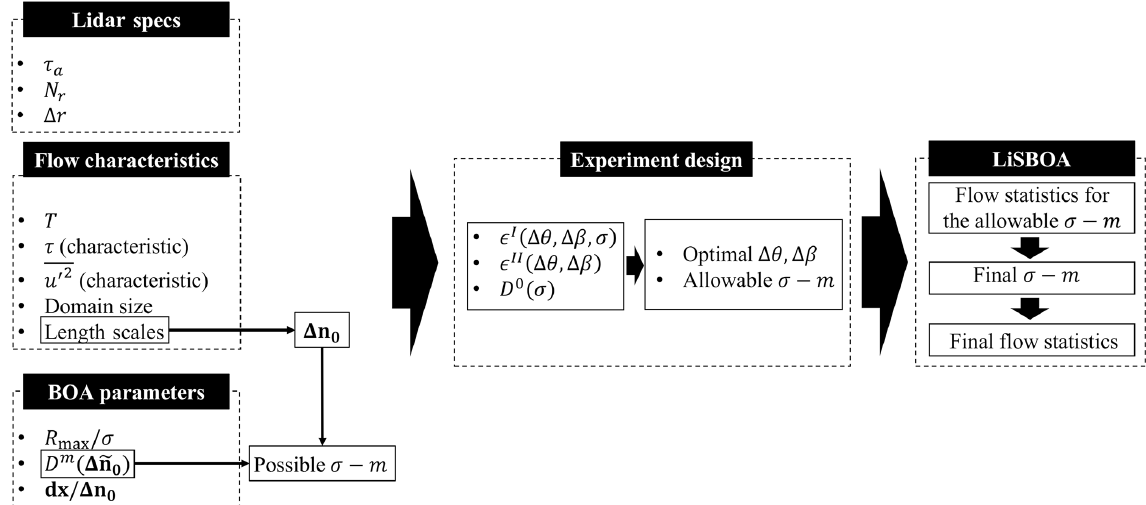
Figure 7. Schematic of the LiSBOA procedure for the optimal design of lidar scans and reconstruction of the statistics for a turbulent ergodic flow.